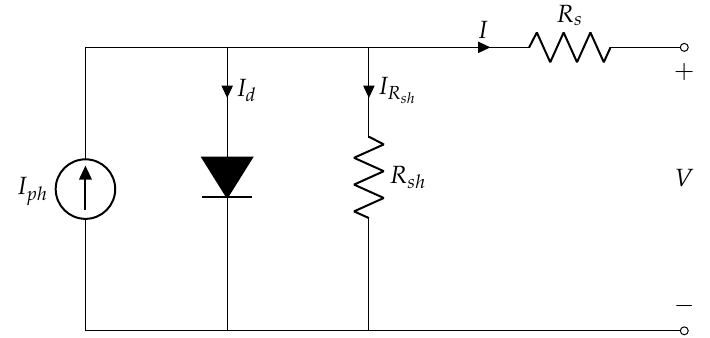
Figure 2. Electrical circuit of a photovoltaic